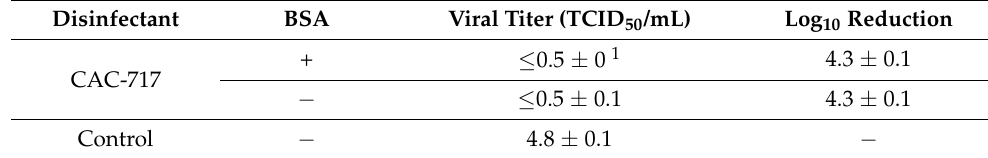
Table 4. Virucidal effect of CAC-717 with organic matter